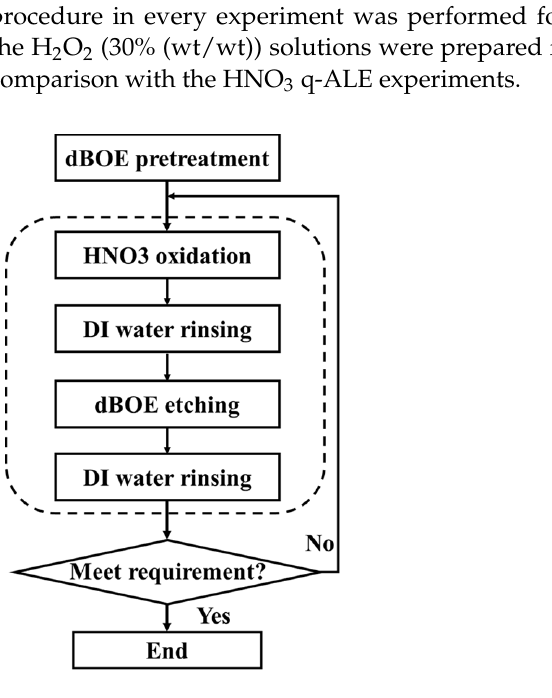
Figure 2. Flow diagram of the main process of digital etching.